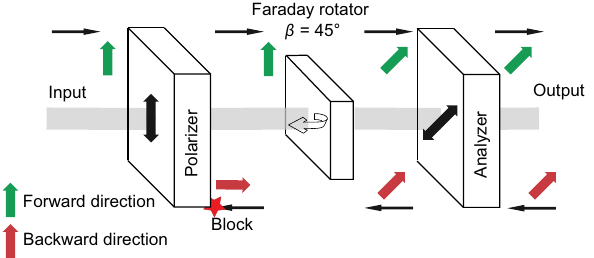
FIG. 7. Optical configuration of a polarization-sensitive opti- cal isolator.